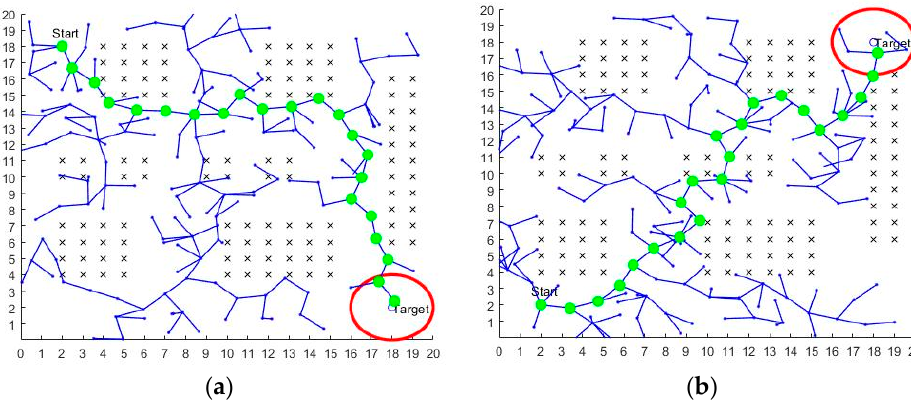
Table 6. Comparison of path-planning time based on Figures 18a and 11a (unit: s).